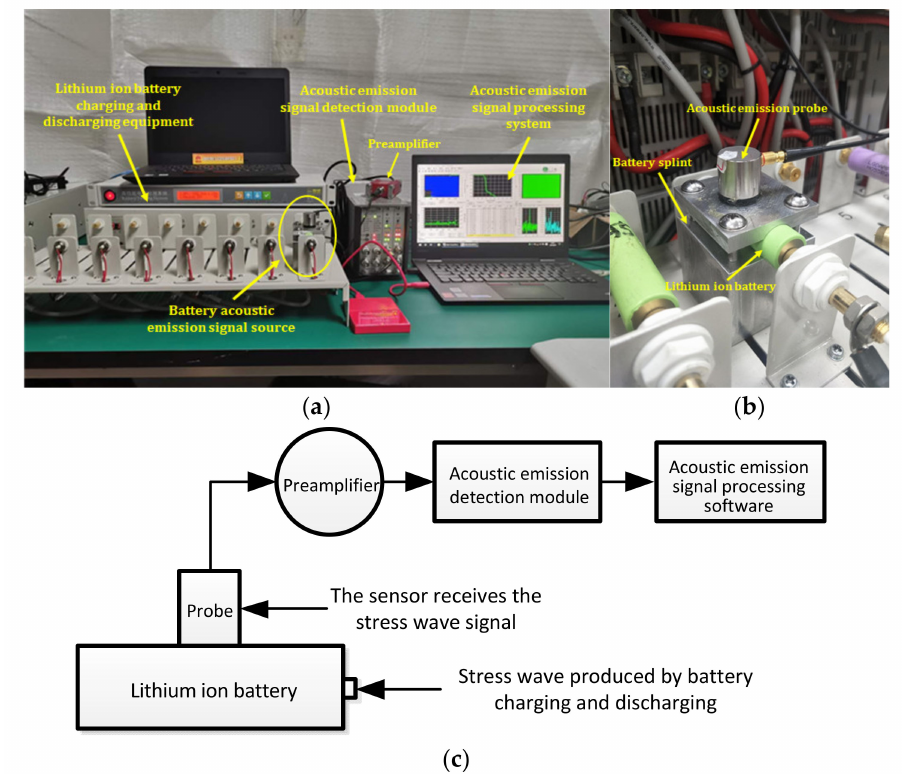
Figure 3. Test system diagram. ( a ) Experimental device diagram; ( b ) Position relationship between the clamp plate and the lithium ion battery; ( c ) Block diagram to the